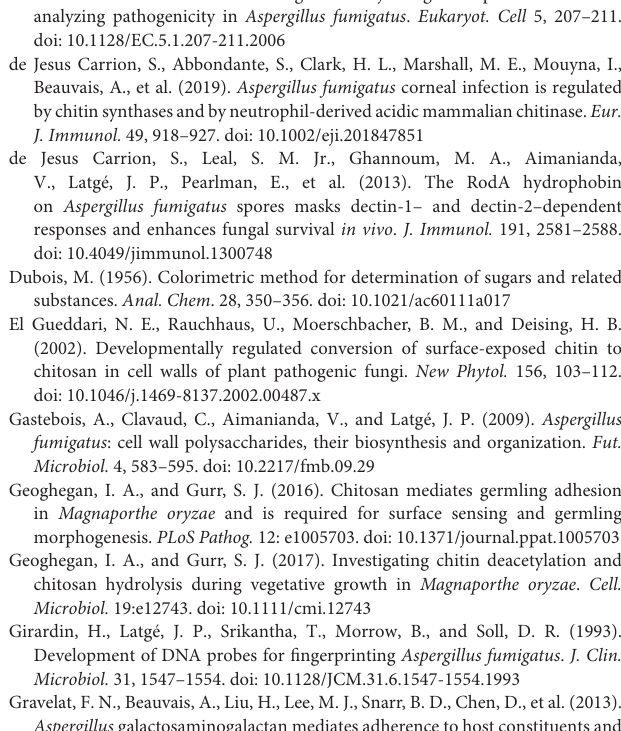
Figure S3 | Growth on agar Malt medium of the parental strain KU80, the single deletion 1 cda mutants as well as the 1 cda1-7 deletion mutant. Figure S4 | Growth on agar glucosamine-MM medium of the parental strain KU80, the single deletion 1 cda7 mutants as well as the 1 cda1-7 deletion mutant. Figure S5 | Transcription factor gene expression level by QPCR on GlcNAc-MM medium. Gene expression data expressed as 2 − 11 Ct are the mean of at least three replicates ± standard error and were calculated as the ratio of the target gene compared with the Elongation factor 1 (EF1 α ) gene used as a reference. Figure S6 | Virulence of 1 cda deficient strain in a mice model of invasive aspergillosis. A total of 16 animals were infected by each strain. (A) Survival of immunosuppressed mice infected intranasally with A. fumigatus parental strain KU80 and 1 cda1-7 mutant and of uninfected strain (B) Quantification of fungal burden in lung homogenates of mice after 4 days of infection using pulmonary galactomannan content as a surrogate measure. Error bars indicate standard errors. Figure S7 | Role of the Cdas in A. fumigatus survival in corneal infection. CFU of infected corneas for the parental strain KU80 and the 1 cda 1-7 mutant. Each data point represents a single infected cornea. Significance was determined by student’s T -test to compare two groups. P -values: ∗ < 0.05, ∗∗∗ < 0.0001. Experiments were repeated three times with similar results. Table S1 | Primers used in this study. Table S2 | Characteristics of A. fumigatus CDA family. Table S3 | Percent of identity between the A. fumigatus CDA family members, CDA from C. lindemuthianum (Cl CDA-col) and CDA1 from S. cerevisiae (Sc),